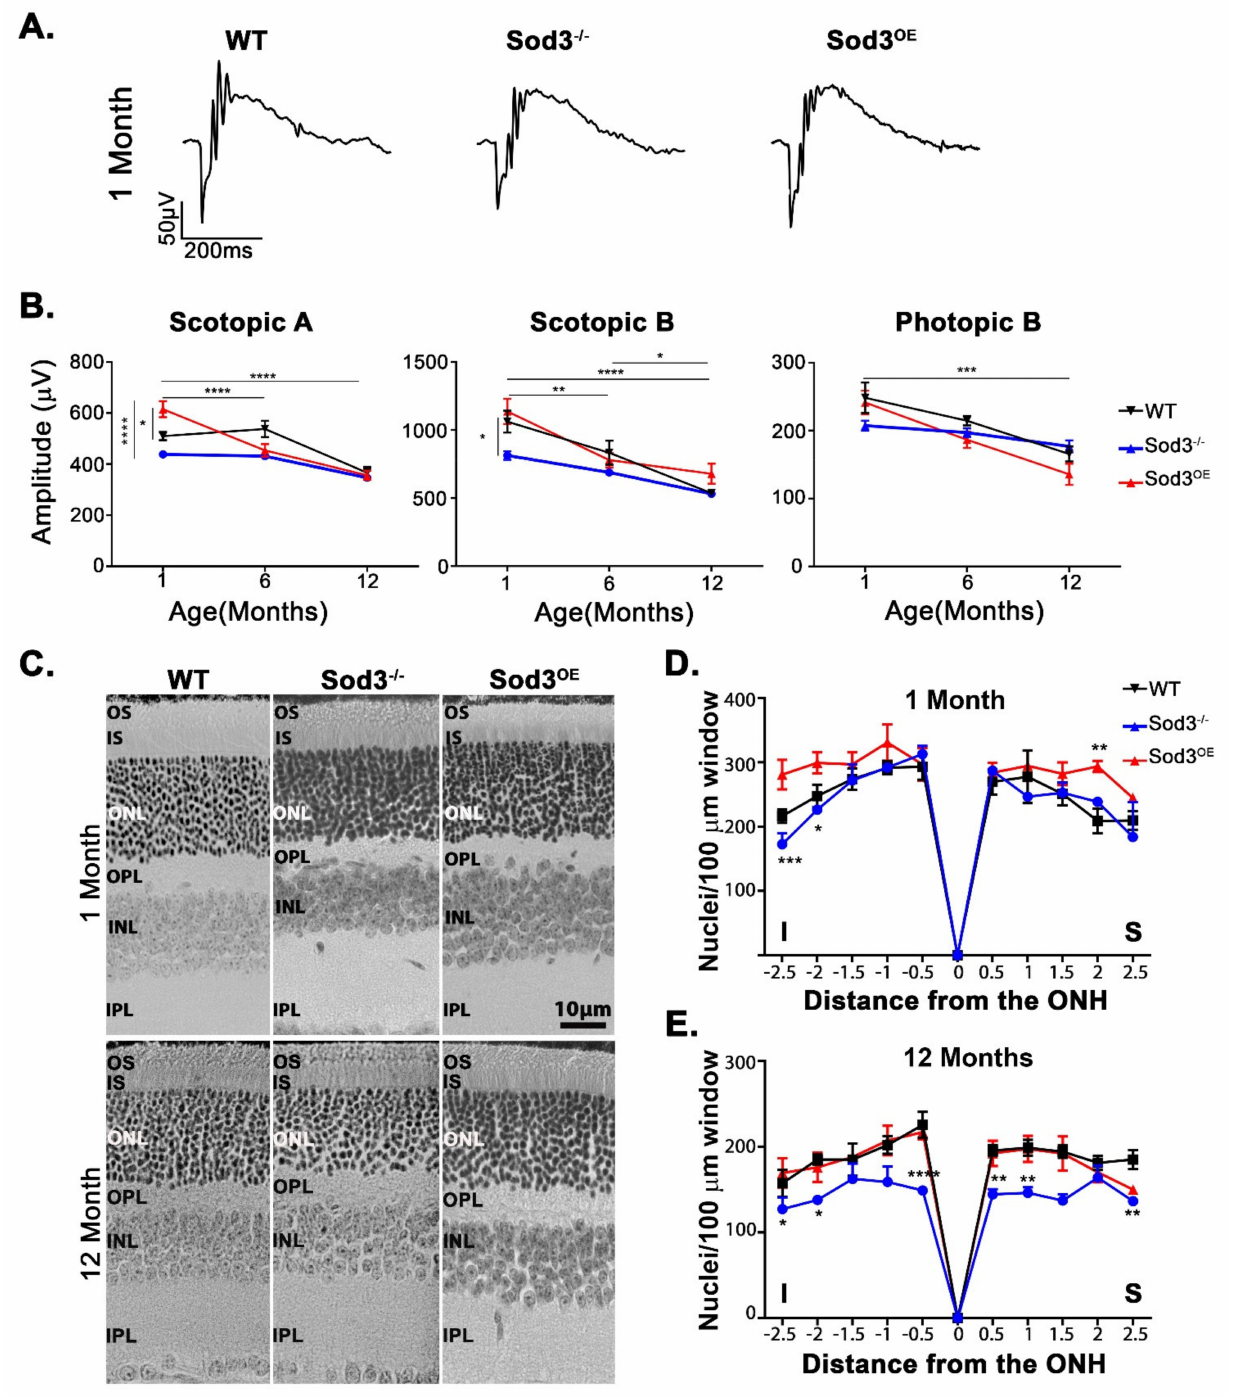
Figure 3. Functional testing and histologic assessments of Sod3 − / − and Sod3 OE retinas. ( A ) Traces of representative responses from the designated genotypes at 1 month. ( B ) At 1 month, the scotopic a-wave response, was markedly elevated in the Sod3 OE retinas over the WT and knockout ( p < 0.0200 and p < 0.0001 respectively). Over time scotopic a-wave responses decline in all cohorts. The most significant decline was observed in the Sod3 OE retinas. Every stage of decline was statistically significant, from 1 month to 6 months p < 0.0001, and from 1 to 12 months, p < 0.0001. The scotopic b-wave response also showed statistical significant decline in WT and Sod3 OE cohorts. In the WT response from 6 months to 12 months p = 0.0421. In Sod3 OE retinas, the decline of the scotopic b was statistically significant from 1 month to 6 months of age ( p = 0.0027), and from 1 month to 12 months p < 0.0001. Photopic b responses declined in the WT from 1 month to 12 months where p = 0.0004 and in Sod3 OE responses from 1 month to 12 months, where p < 0.0001. Sample size is ≥ 8 for each time point.